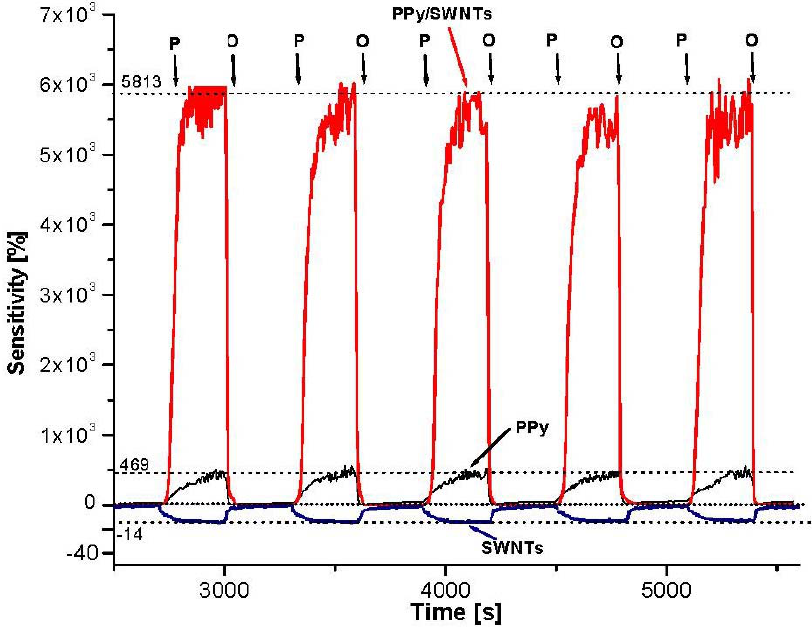
Figure 6. Oxygen sensitivity of PPy, SWNTs and PPy/SWNTs upon exposure to open air (P: low air presure as pump on, O: open